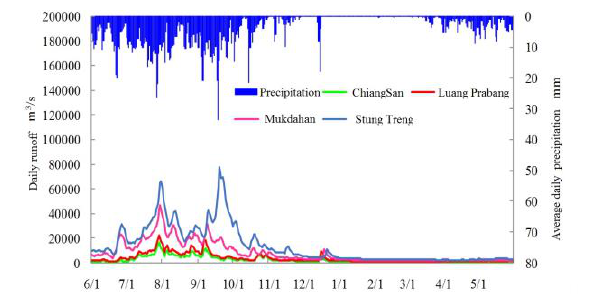
Figure 4. Daily runoff of major hydrological stations in Mekong